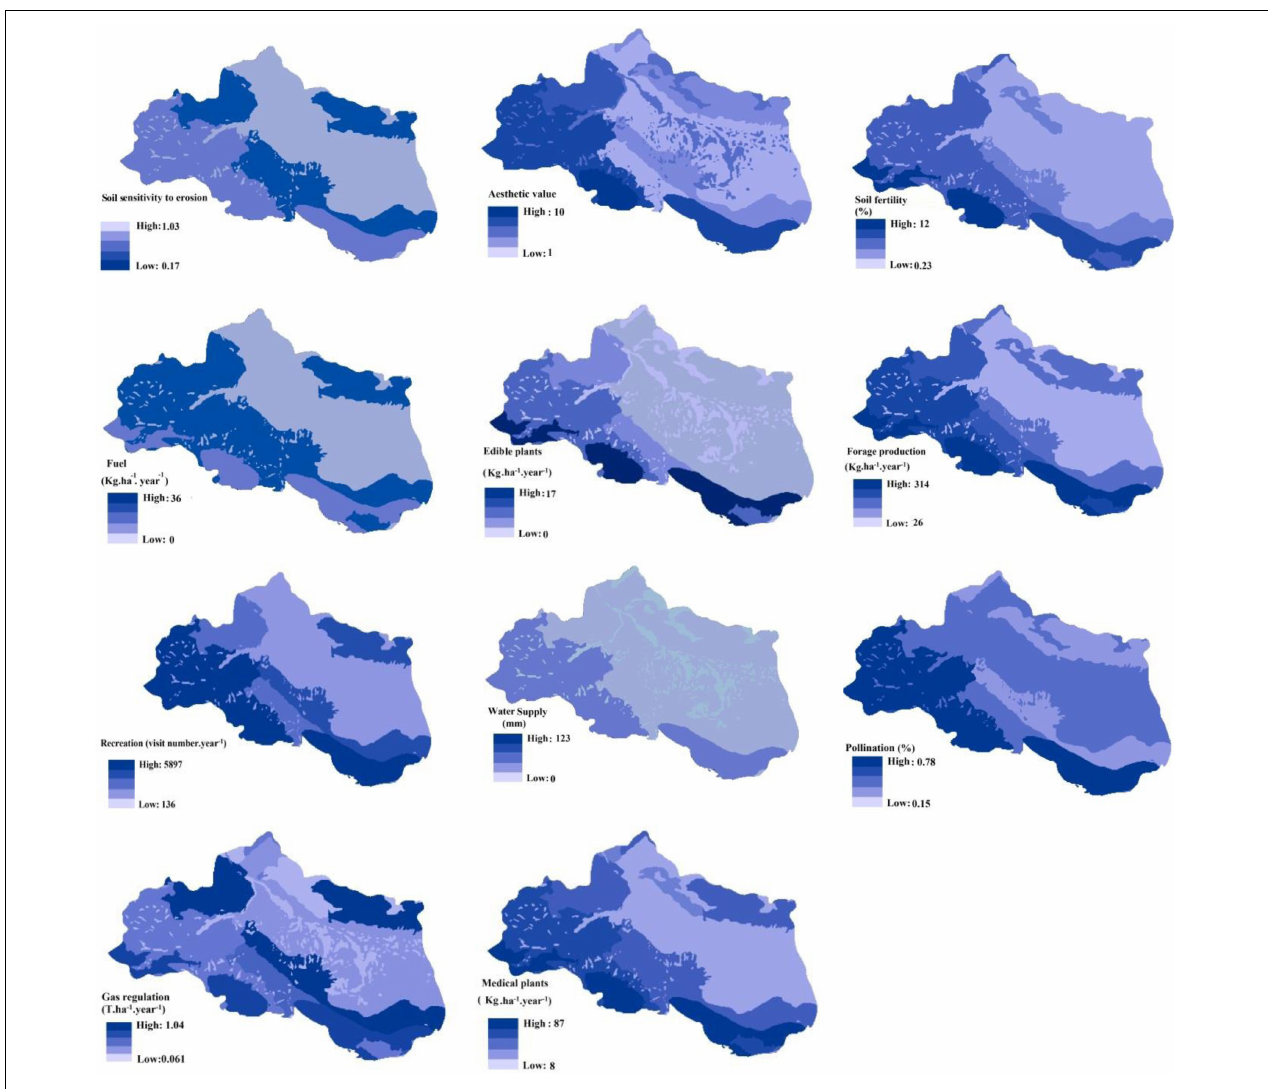
FIGURE 3 | Spatial distribution of the ecosystem services (soil sensitivity to erosion, soil fertility, aesthetic value, fuel, edible plants, forage production, recreation, water yield, pollination, gas regulation, and medicinal plants) along the basin.